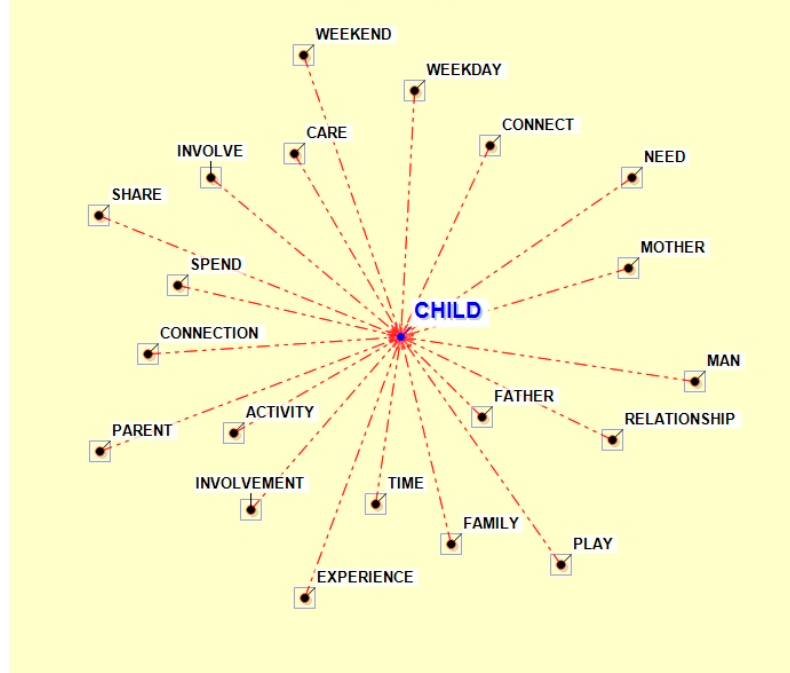
Figure 10. Radial diagram with “child”.